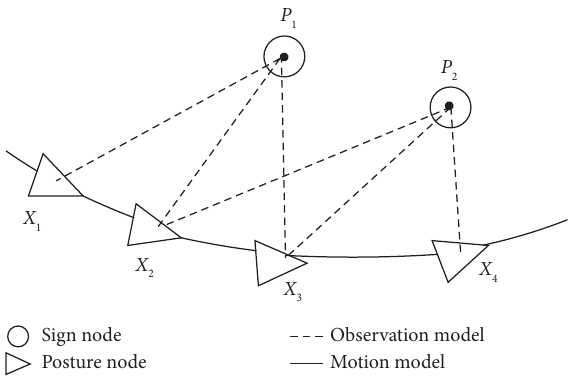
Figure 7: Graph optimization